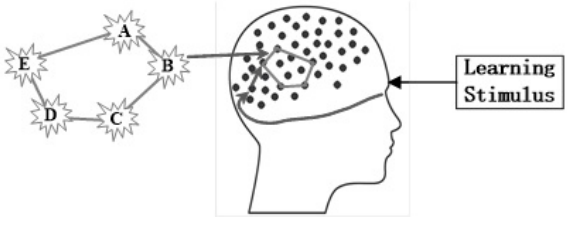
Fig. 1 The process of chunk formation and